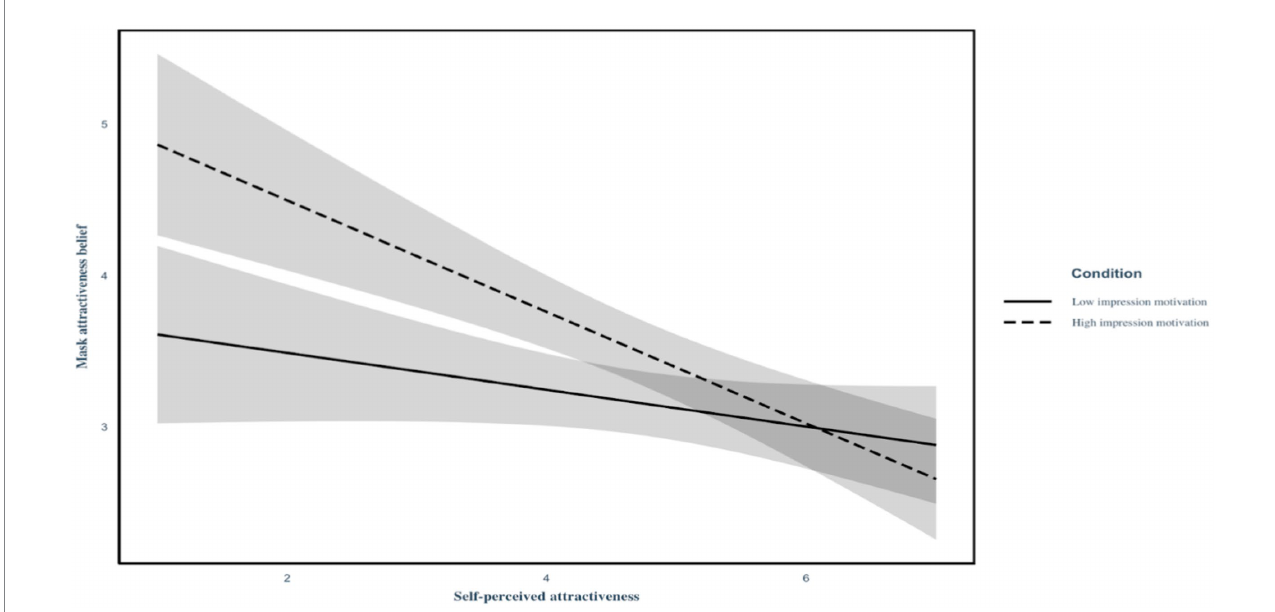
FIGURE 2 Regression slopes for the interaction of self-perceived attractiveness and the conditions on mask attractiveness belief in Study 3 ( N = 442). Mask attractiveness belief = belief that wearing a face mask enhances perceived attractiveness. Self-perceived attractiveness was mean-centered prior to